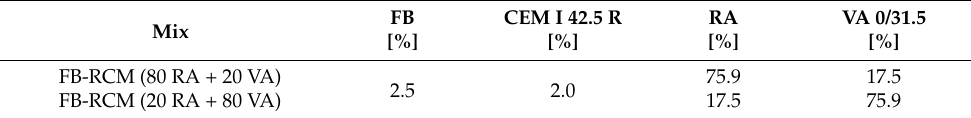
Table 7. Composition of recycled mix with recycled aggregate (RA).